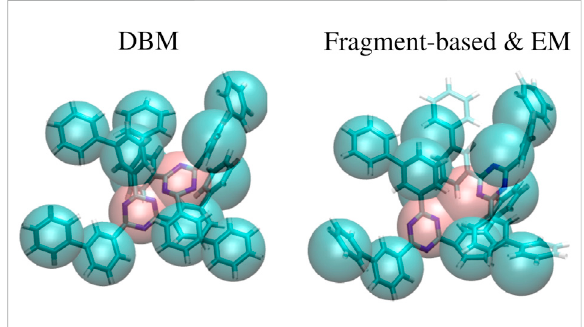
FIGURE 4 Superposition of a CG conformation from the generalization test set and backmapped conformation obtained with DBM (left) and EM scheme (right). The CG structure yields too close atomic contacts upon backmapping with DBM, while the AA conformationobtained withtheEMscheme isshiftedfromtheCG